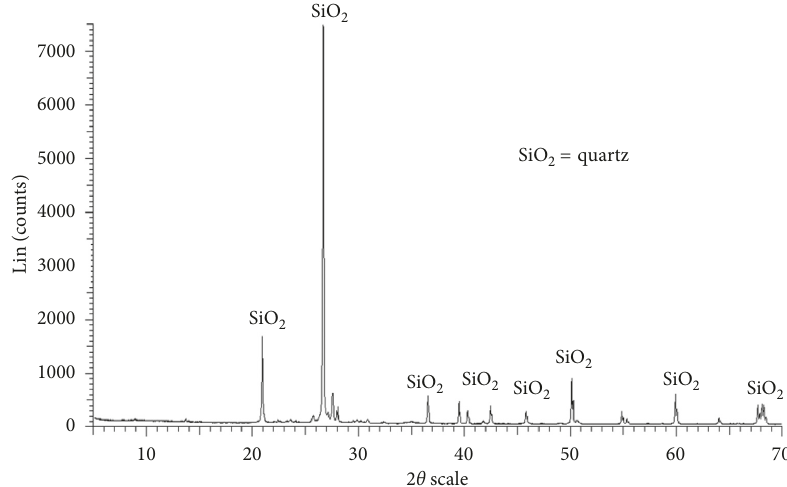
Figure 3: X-ray diffraction pattern of a SGRS with a characteristic crystalline peak.